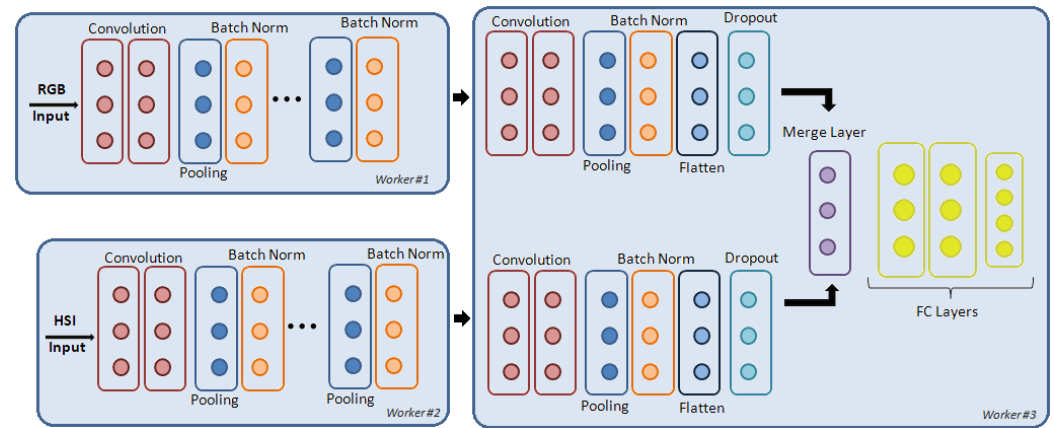
Figure 5. The optimized architecture. The architecture is similar to the “baseline” case, however, intermediate results from convolution layers are communicated amongs